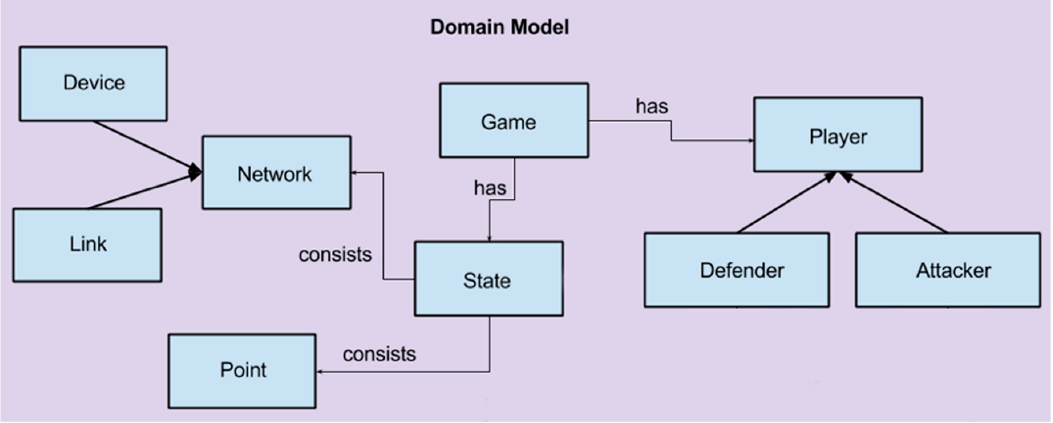
Figure 5. PDSSS domain model (truncated to only include Pareto Optimization).